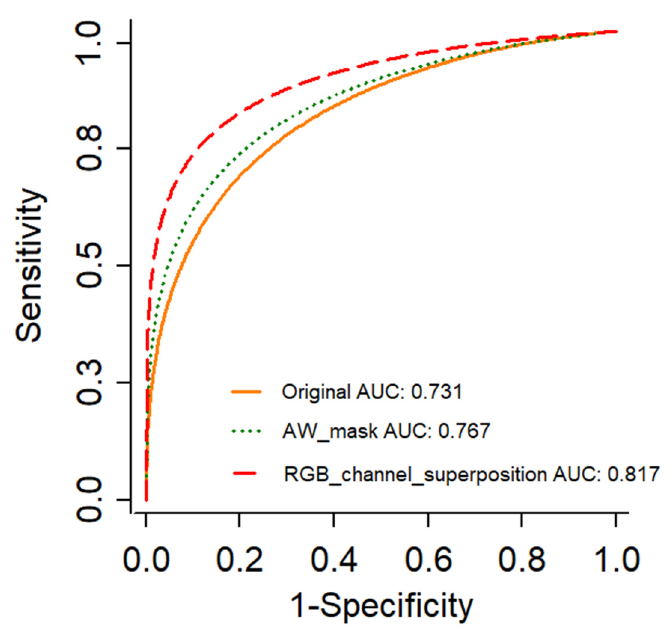
Figure 5. ROC graph and AUC of the original, acetowhite mask, and RGB channel superposition